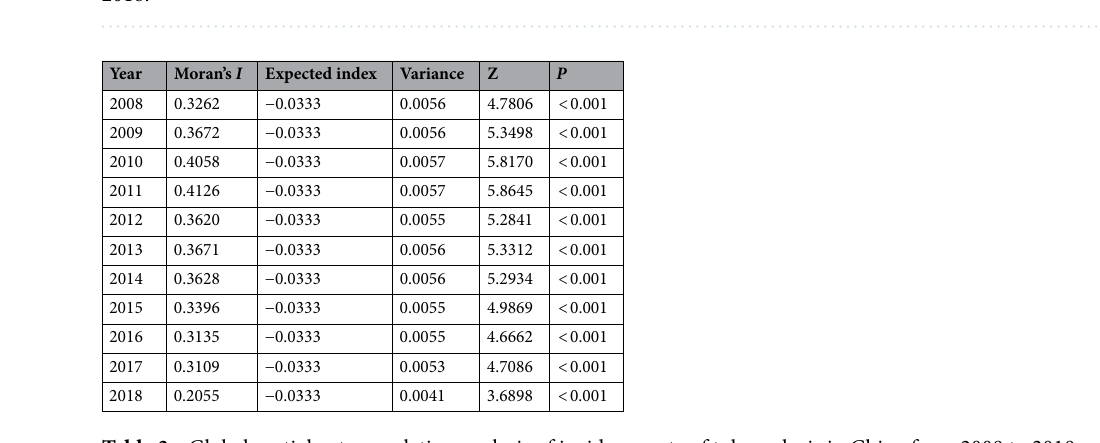
Table 3. Global spatial autocorrelation analysis of incidence rate of tuberculosis in China from 2008 to